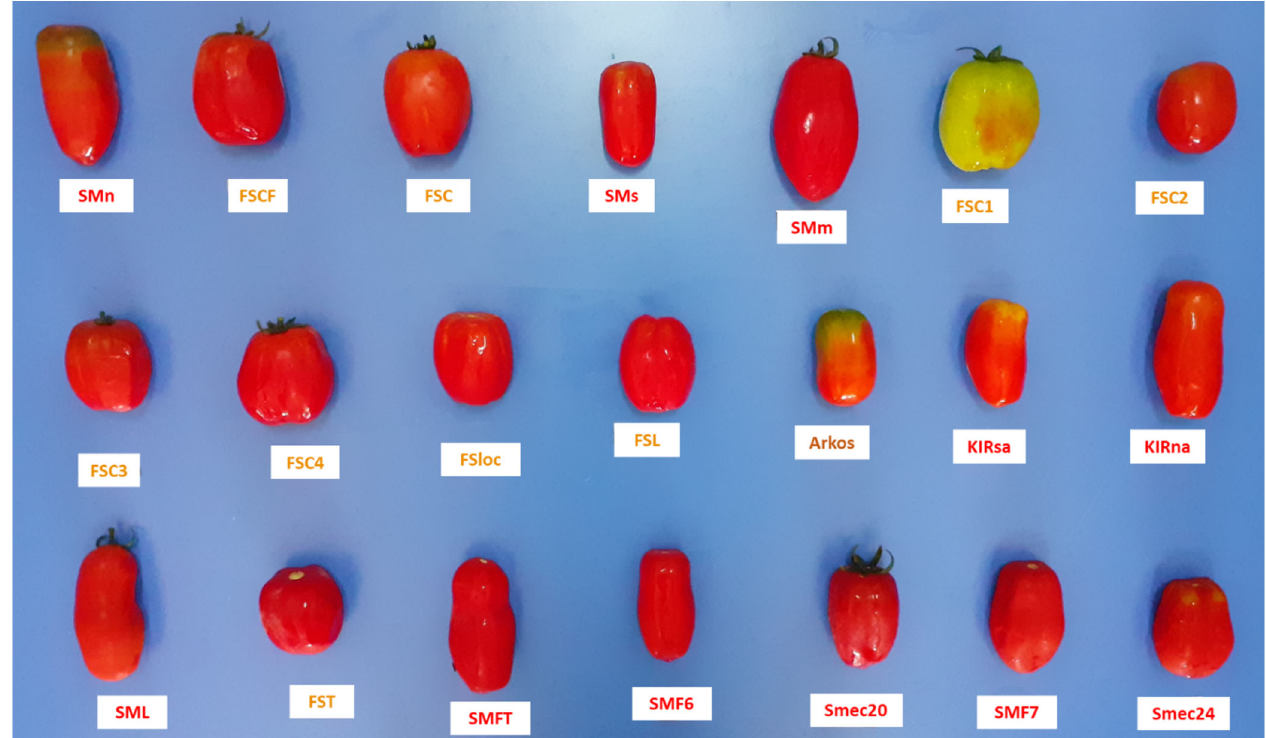
Figure 2. Details of fruit morphology of the tomato accessions considered in the study. In orange and red labels are indicated ‘Re Fiascone’ and ‘San Marzano’ landraces, respectively.